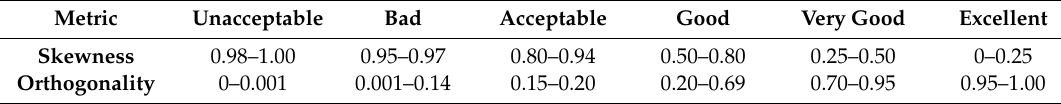
Table 6. Metrics spectrum for skewness and orthogonal quality of computational mesh